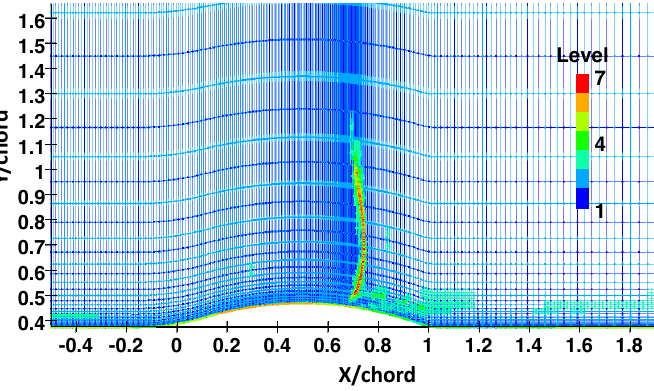
Figure 8. WA-URANS of Bachalo-Johnson flow: adaptive mesh. The colored contours represent the adaptive mesh resolution levels.